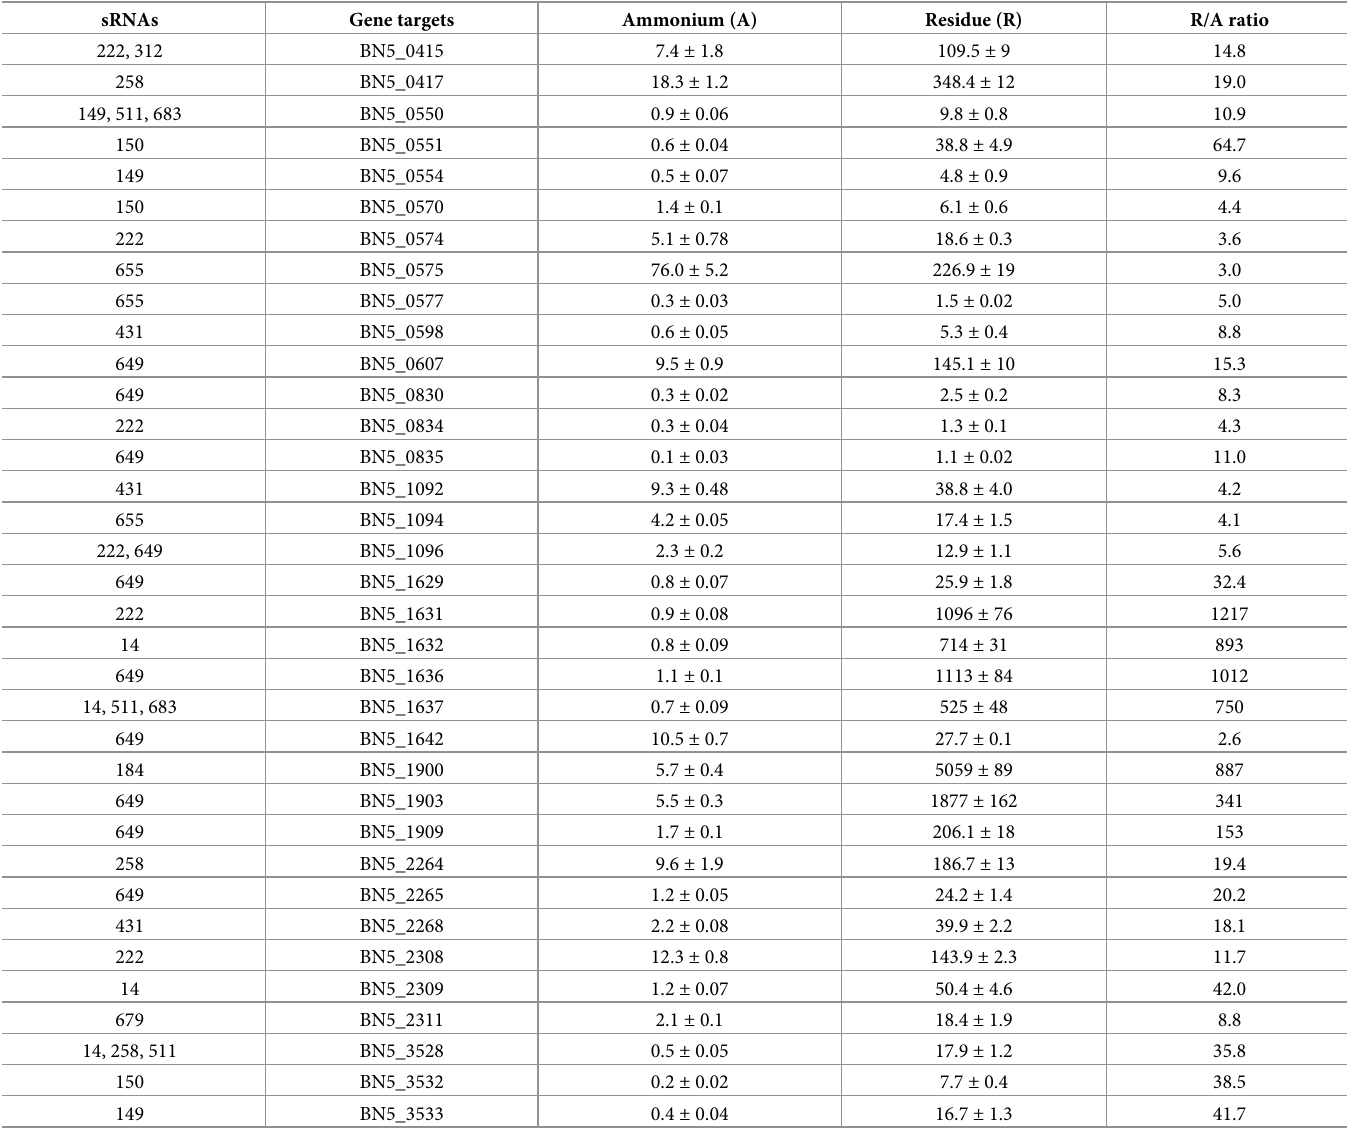
Table 2. Quantitative RT-PCR of sRNAs target